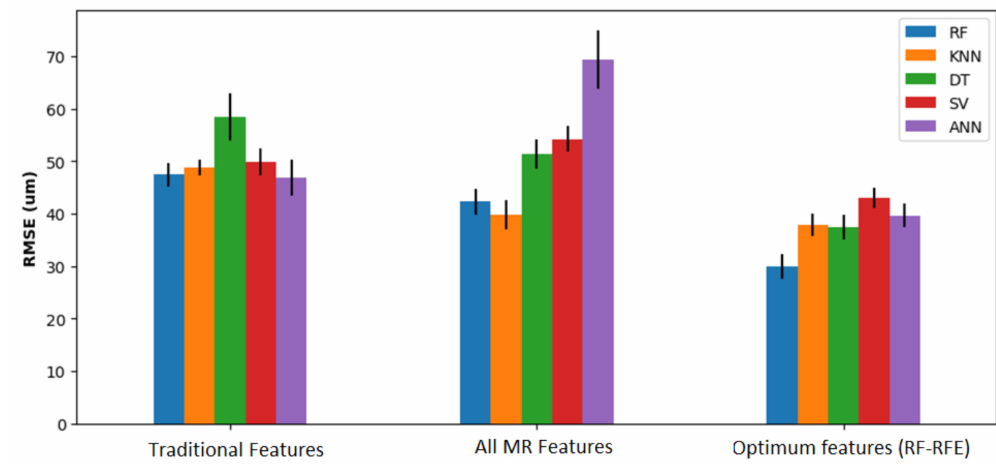
Figure 12. RMSE error in flank tool wear prediction using different ML models and different set of predicting features (lower is